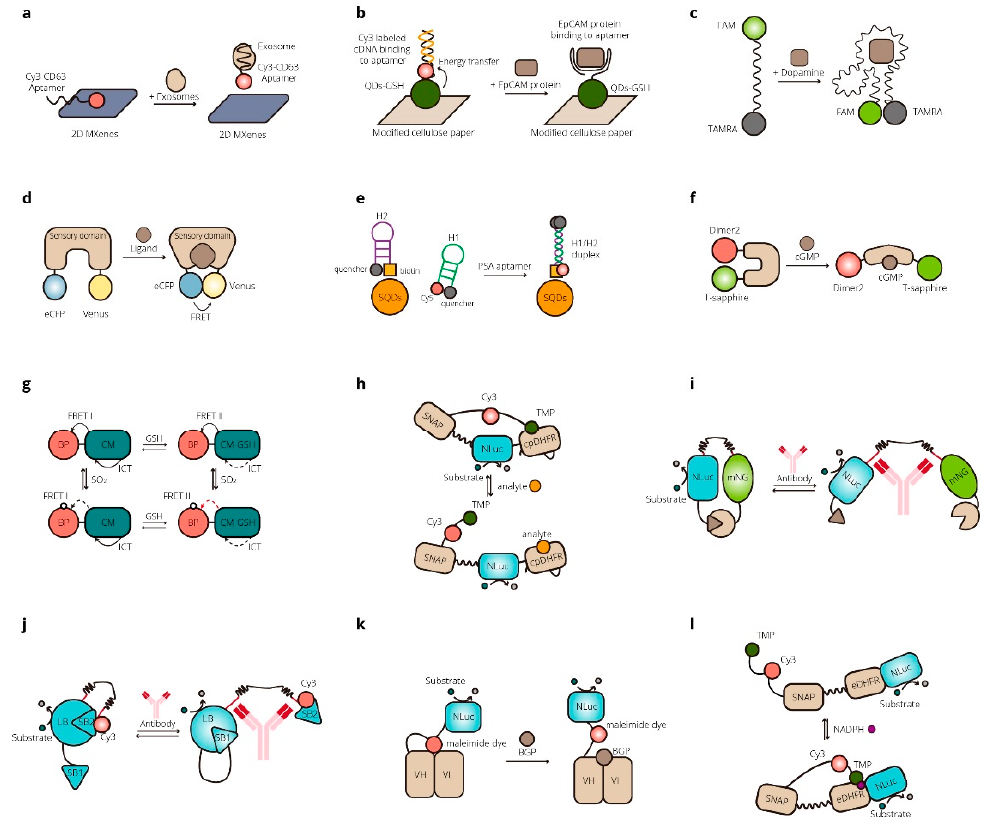
Figure 2. FRET- and BRET-based biosensors for biomedical applications. ( a ) A self-standard ratio- metric, highly sensitive FRET platform for detecting exosomes [57]. ( b ) A FRET-based bioassay for the recognition of an epithelial cell adhesion molecule (EpCAM) [58]. ( c ) A folding-based FRET sensor for dopamine [59]. ( d ) A biosensor for the real-time optical tracking of isoleucine in living cells [60]. ( e ) A biosensor based on FRET and catalytic hairpin assembly for the detection of polysialic acid by use of a new DNA aptamer [61]. ( f ) A highly sensitive FRET biosensor for measurement of cGMP in cardiomyocytes and neurons [62]. ( g ) An ICT-FRET integration platform for the